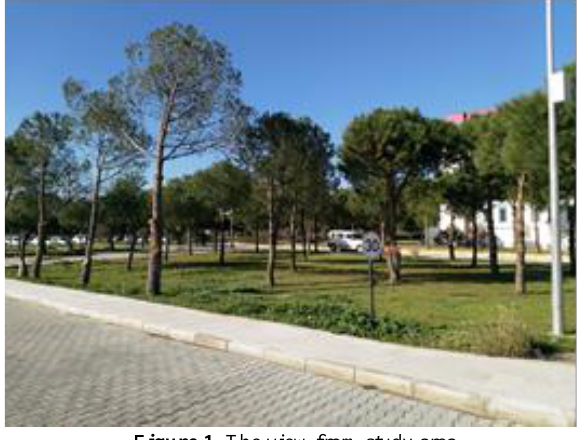
Figure 2 . TORCH handheld mobile laser scanner (upper) and sample view of 7-inch touch screen on device